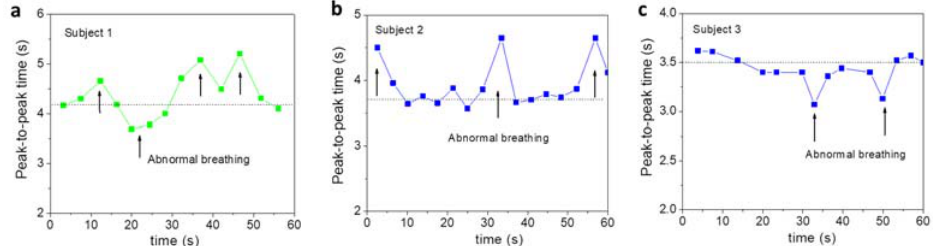
Figure 3. Peak-to-peak time as a function of time for three subjects aged ( a ) 30, ( b ) 36, and ( c ) 42 years old. These abnormal breathing patterns are related to those seen in Figure 2.